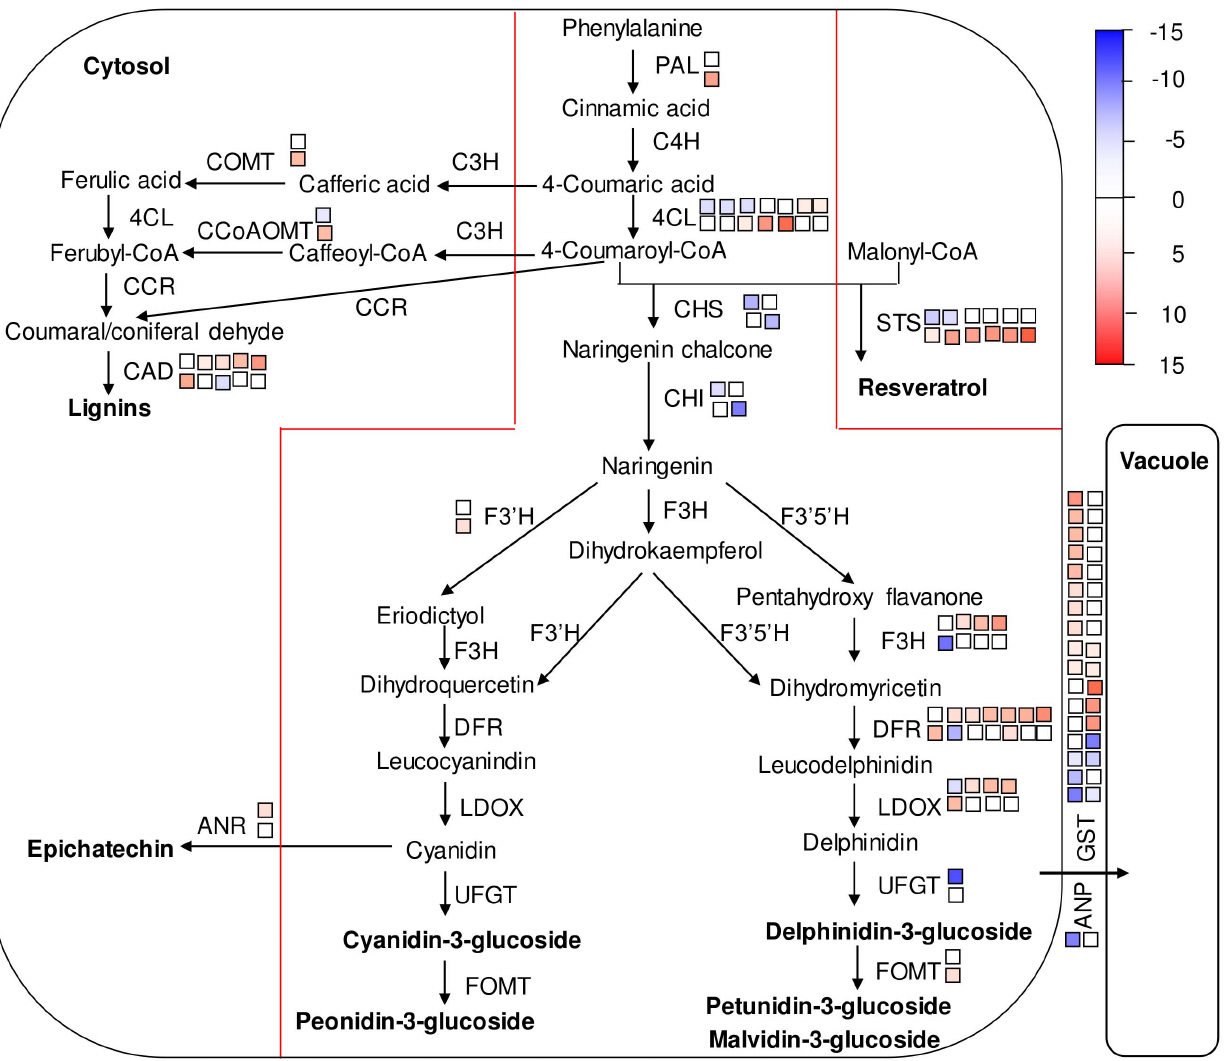
Figure 4. Overview of the phenylpropanoid pathway modulation. For each gene, the upper squares represent ‘Jingxiu’ and the lower squares ‘Jingyan’, while the number of squares represents the copy number of each gene. Different colors represent down-regulated or up-regulated genes in ‘Jingxiu’ and ‘Jingyan’ berry skin (sunlight exclusion versus exposure) with log2 ratio $ 2 at P , 0.0001.